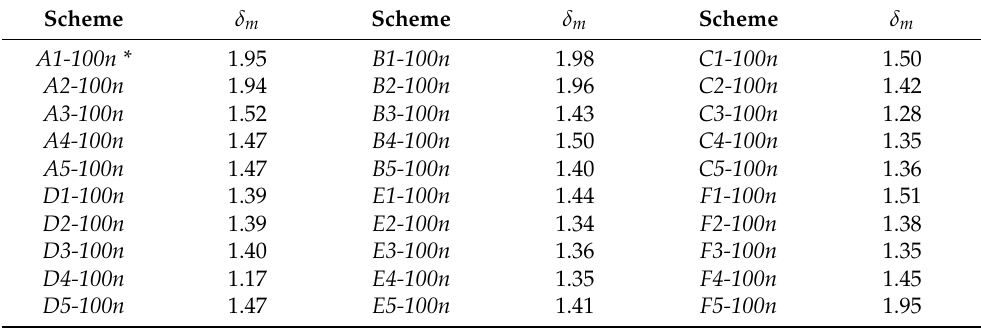
Table A1. A full list of the final δ m values of the substrates that were treated with different schemes shown in Table 1 before 100 nm-thick gold coating.